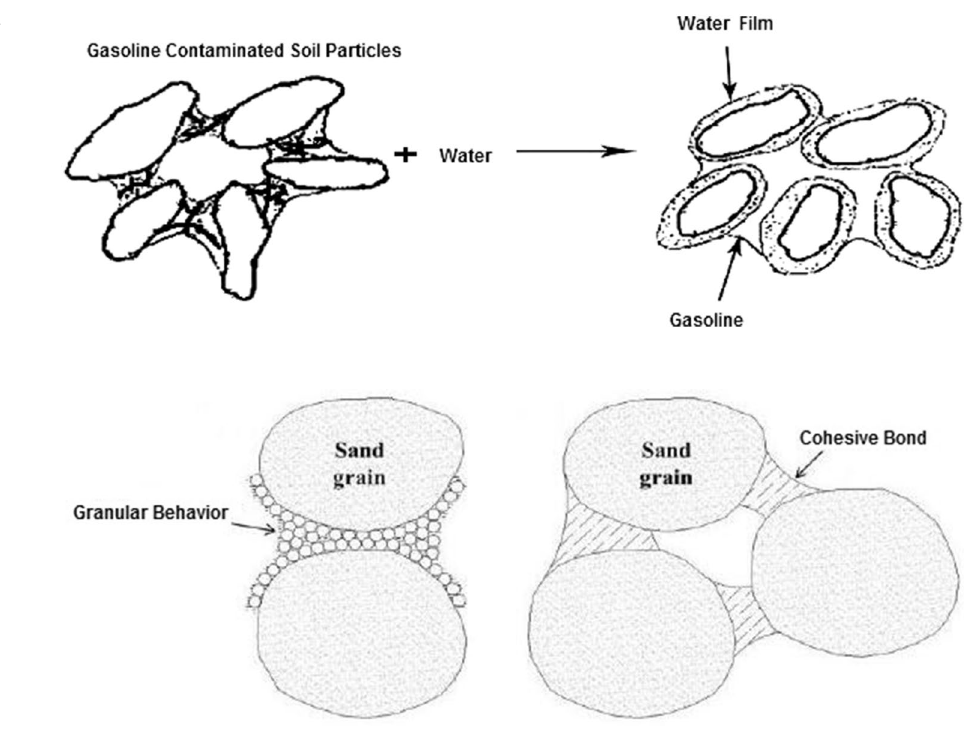
Fig. 30 Separation and behav- ior of contaminated soil by adding water